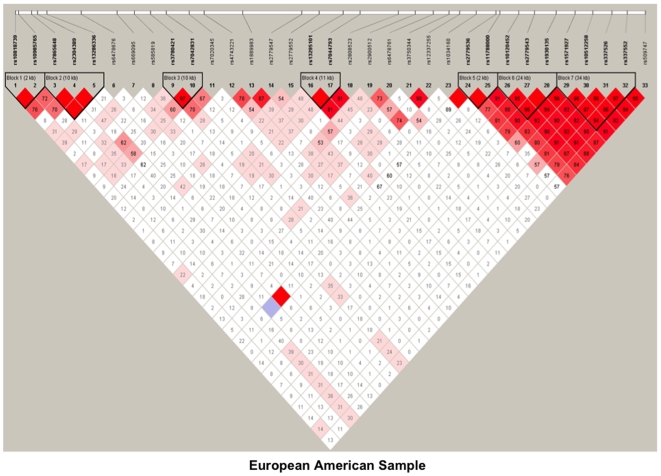
Linkage disequilibrium (LD) map of 33 SNPs within GABBR2 in European American sample.Dark red denotes high LD (D′ = 1 and LOD >2). Lower LD values are represented in shades of pink (0.21<D′<1 and LOD >2). White represents low LD and low LOD (LOD <2). Numbers indicate the D′ statistic for two consecutive SNPs. LD blocks were defined using Haploview [25].